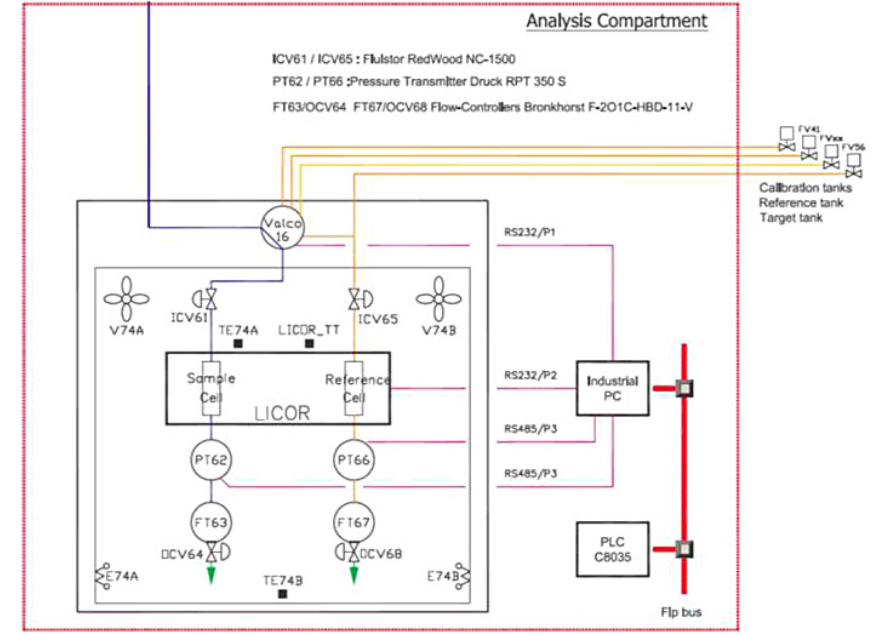
Figure 3. Schematic of CARIBOU CO 2 analyser component.